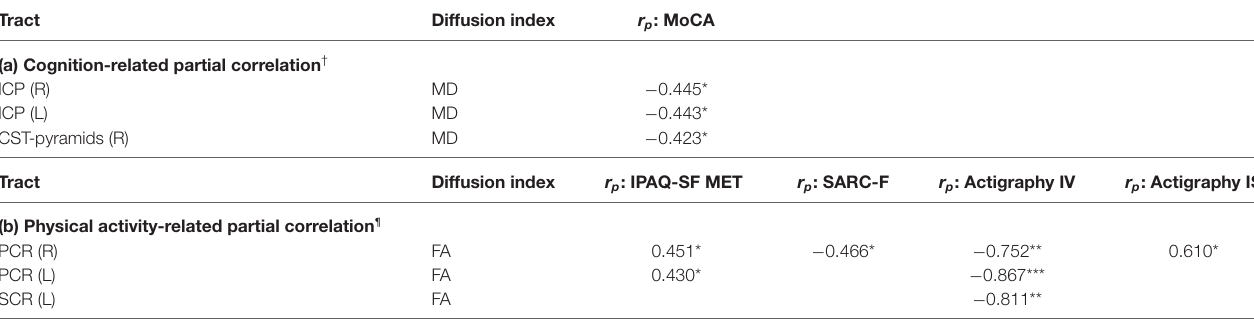
TABLE 5 | Partial correlation analysis of diffusion indices and clinical scales by controlling physical-cognitive interaction in SCD. Tract Diffusion